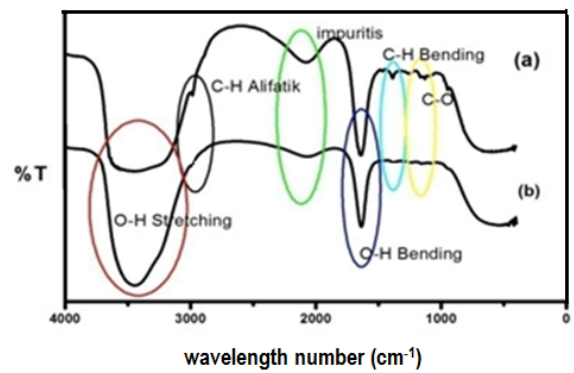
Figure 10: FTIR spectrum of isopropanol before (a) and after degradation with TiO /C as catalyst (b). 2